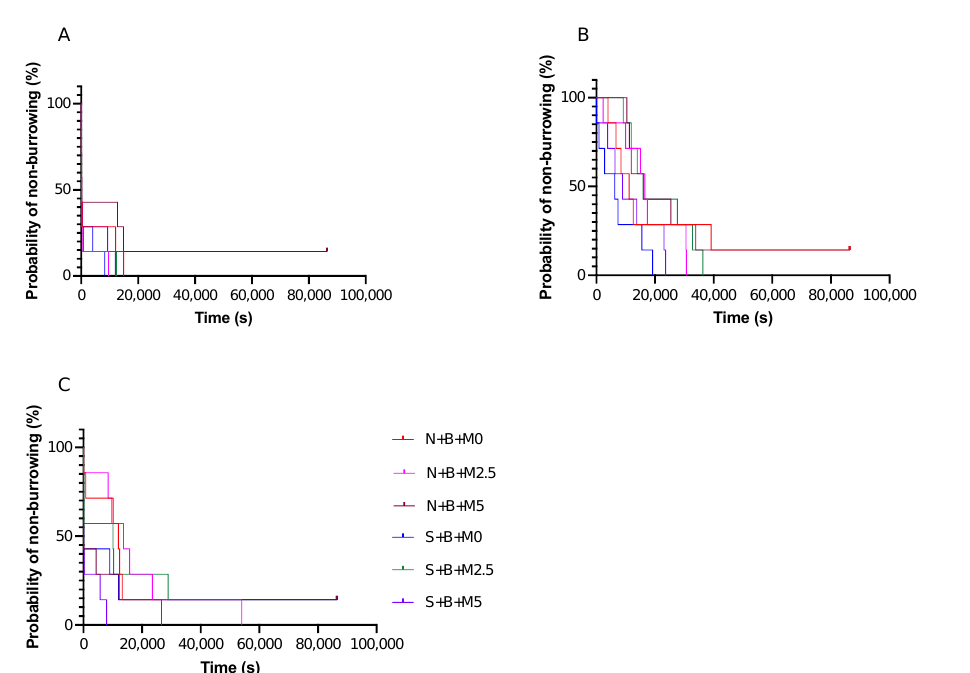
Figure 5. Kaplan–Meier analysis of the latency to burrow: ( A ) Day pretreatment. ( B ) Day 1 post- treatment. ( C ) Day 2 post-treatment. N + B + M0 group: n = 7; N + B + M2.5 group: n = 7; N + B + M5 group: n = 7; S + B + M0 group: n = 7; S + B + M2.5 group: n = 7; and S + B + M5 group: n = 7.